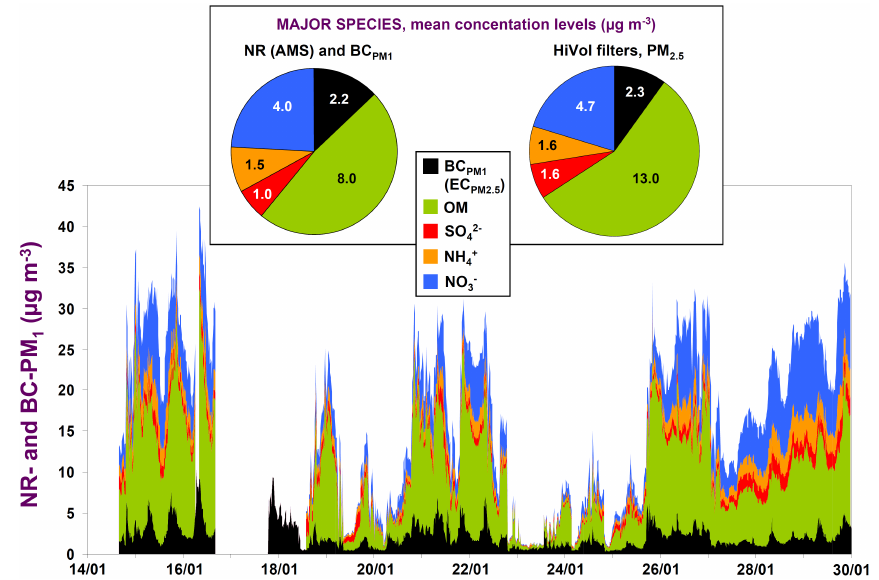
Figure 1 Fig. 1. Time series and mean concentration levels of the main components of the fine aerosol fraction during the period of study. Due to technical issues, AMS measurements are not available from 16/01 to 18/01. Mean PM 2 . 5 concentrations and BC PM1 were calculated during the same periods than AMS measurements (upper panel).